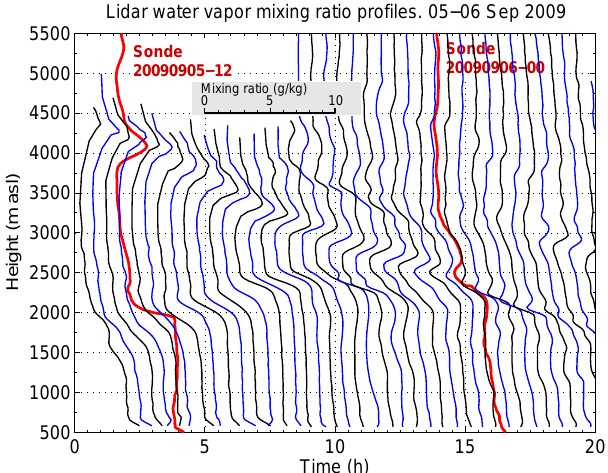
Fig. 1. Lidar water vapor mixing ratio profiles time series. Lidar profiles are plotted in blue and black with a 30min time resolution. Each successive profile is shifted to the right by 30min on the x-axis. The mixing ratio scale is shown in the plot window. Collocated radiosonde profiles are super-imposed in red. This plot illustrates the lidar capability of filling the information gap between radiosonde profiles. The lidar provides a profile every 30min, whereas radiosondes are available only twice a